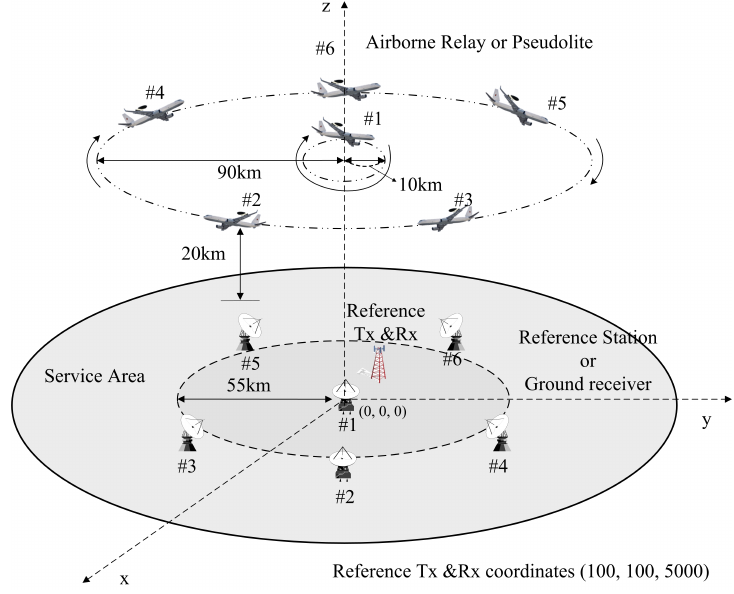
Figure 5. Segment disposition for